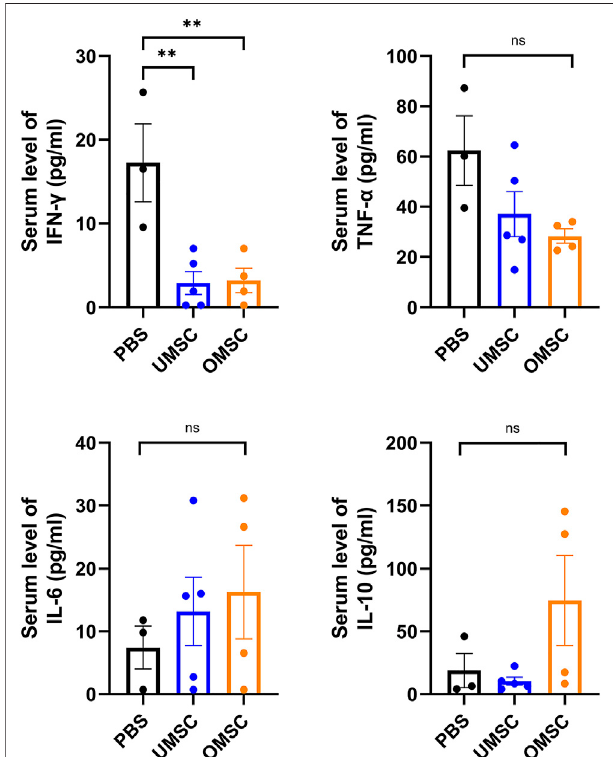
FIGURE3 | Effects ofearly intervention ofOMSC and UMSC treatments onserumin fl ammatorycytokinesinEAEmice:serumIFN- γ ,TNF- α ,IL-10,and IL-6 levels in the OMSC treatment group ( n (cid:1) 4), UMSC treatment group ( n (cid:1) 5), and PBS group ( n (cid:1) 3) of EAE mice. * p < 0.05, ** p < 0.01, ns: the difference was not statistically signi fi cant.